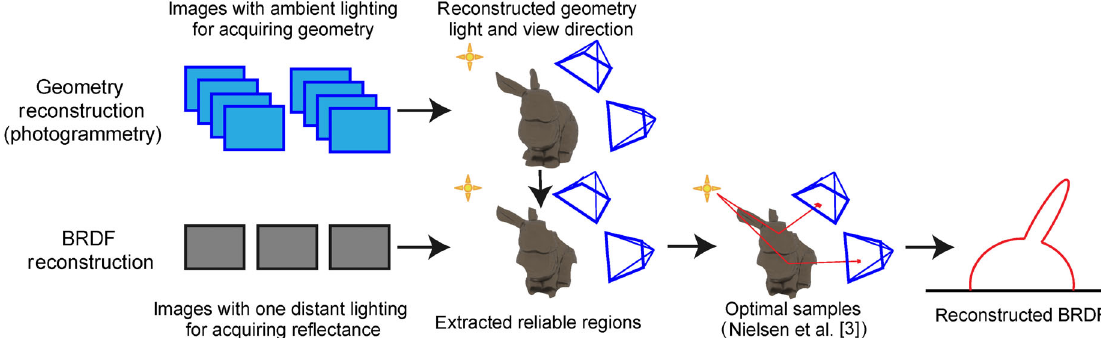
Fig. 3 Overview of our method. First, we obtain multi-view images under ambient lighting to acquire the geometry. We then obtain a few additional images with only one distant light to acquire the reflectance. Note that these distant light images share a viewpoint with one of the corresponding multi-view images. Next, we reconstruct the geometry using PhotoScan . We then extract reliable regions from the reconstructed geometry following assumptions introduced in this paper. Nielsen et al.’s optimal lighting and viewing directions are determined using the acquired lighting and viewing directions, and the reflectance is sampled at corresponding pixels of the distant light images. Finally, we reconstruct the BRDF using these samples.